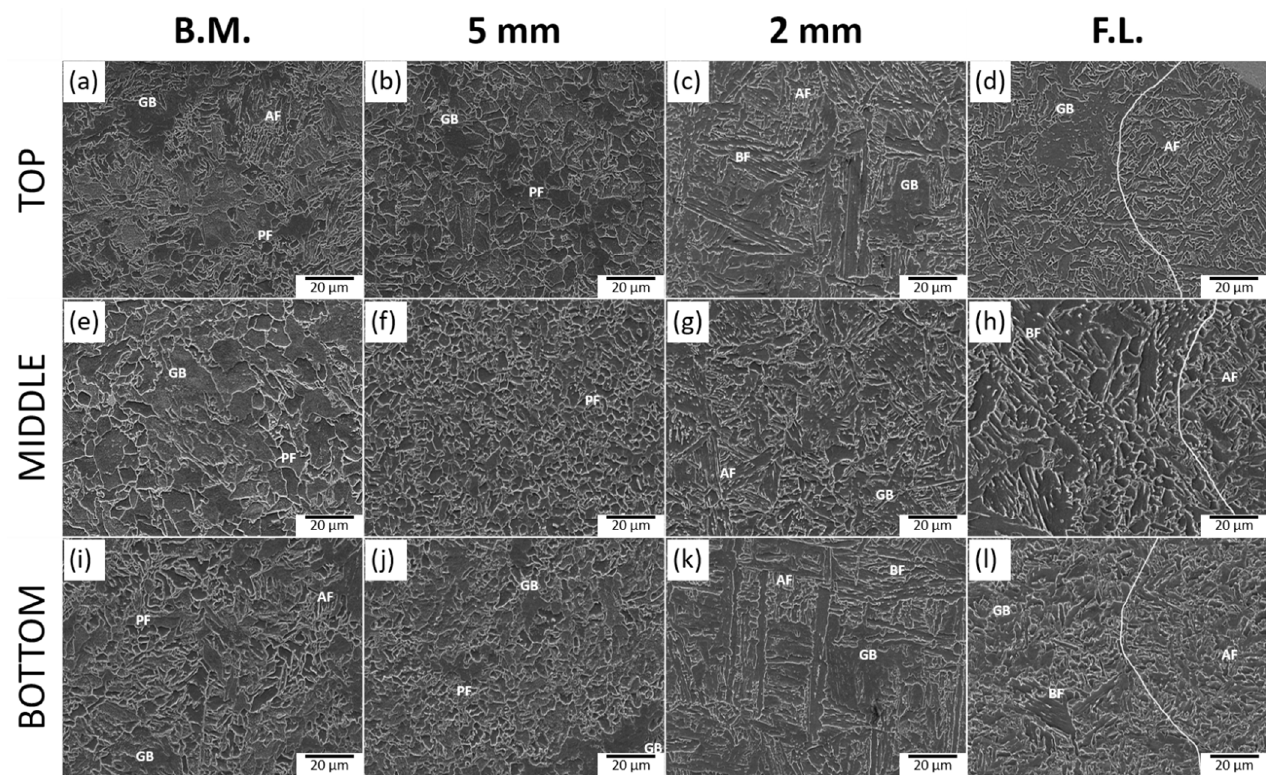
Figure 4. Microstructures of the base metal and HAZ using scanning electron microscopy (SEM): ( a ) base metal, ( b ) 5 mm from F.L., ( c ) 2 mm from F.L., ( d ) F.L. of top; ( e ) base metal, ( f ) 5 mm from F.L., ( g ) 2 mm from F.L., ( h ) F.L. of middle; ( i ) base metal, ( j ) 5 mm from F.L., ( k ) 2 mm from F.L., ( l ) F.L. of bottom.